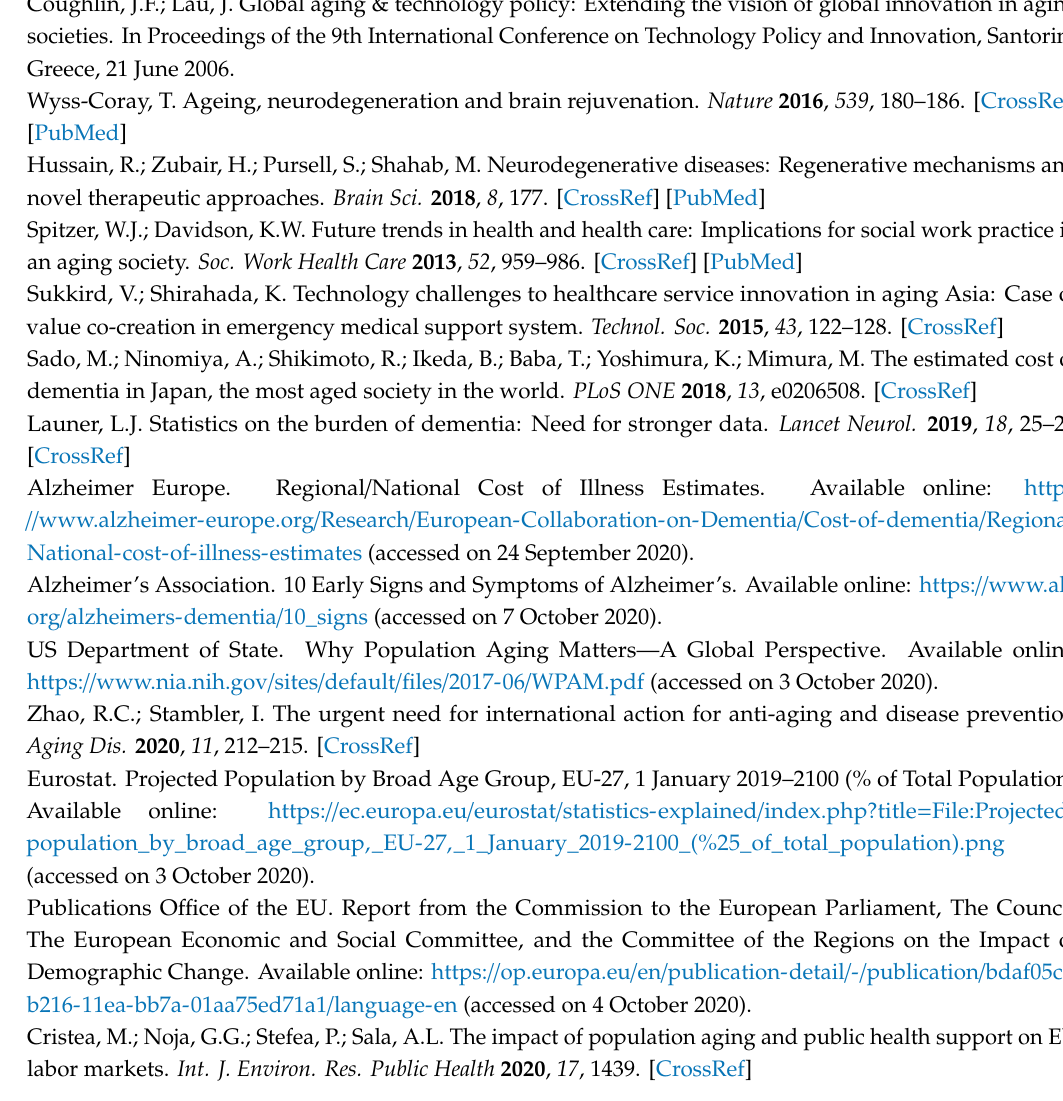
Table S1: The results of comparison between modularity and k-means clustering, Table S2: Cellular and molecular mechanisms of aging (Cluster 1), Table S3: Anti-aging medicine and substances (Cluster 2), Table S4: Clinical-based research on aging-related diseases, medical services, and policies (Cluster 3), Table S5: Aging-related impairment of the brain and cognition (Cluster 4), Table S6: Smart care for older adults (Cluster 5). Table S7: Aging of the immune system (Cluster 6), Figure S1: The curve of the total within-cluster sum of square according to the number of clusters k